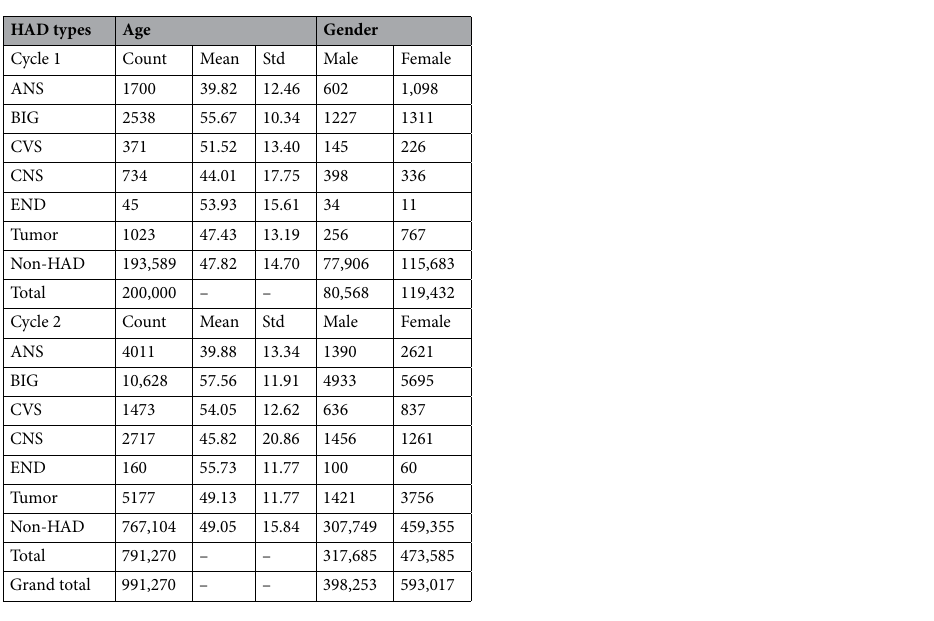
Table 5. HAD type distribution in OPD data